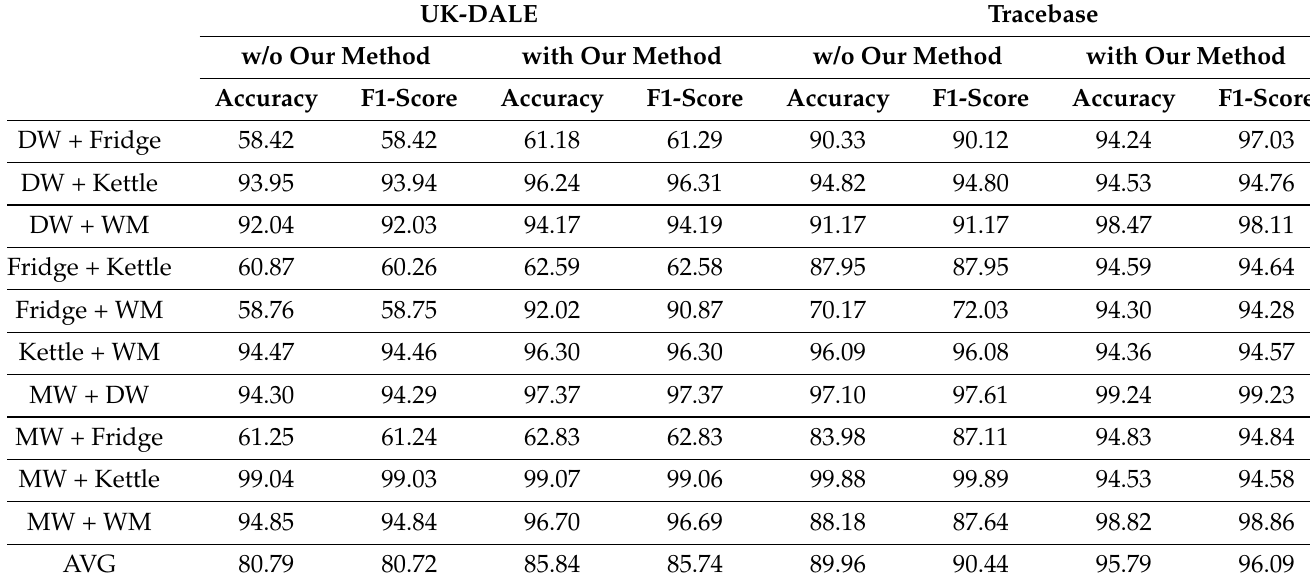
Table 5. The results of combinations of two appliances with VDOCNN.